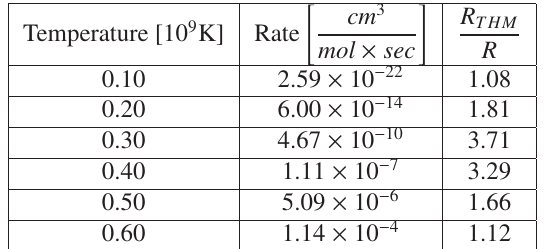
Table 1. Reaction rate and ratio between experimental THM results (R THM ) and the one parametrized from the